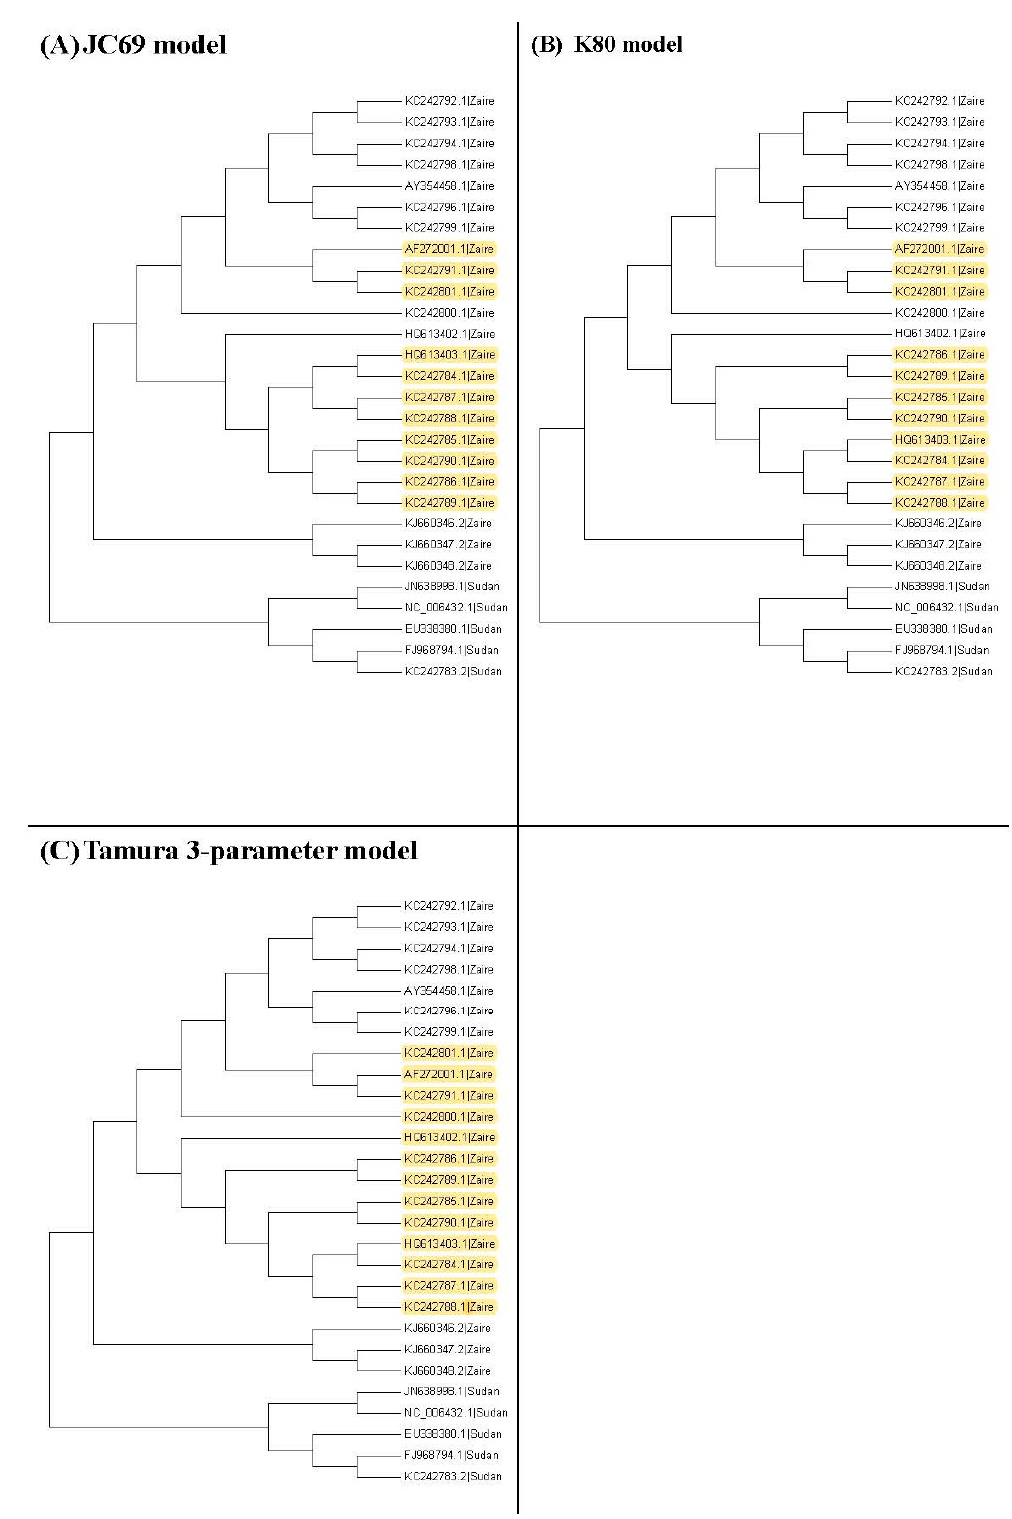
Figure 3. The maximum likelihood trees for the 28 Ebolavirus sequences based on the JC69 model, K80 model, and Tamura 3-parameter model. Yellow color: difference.